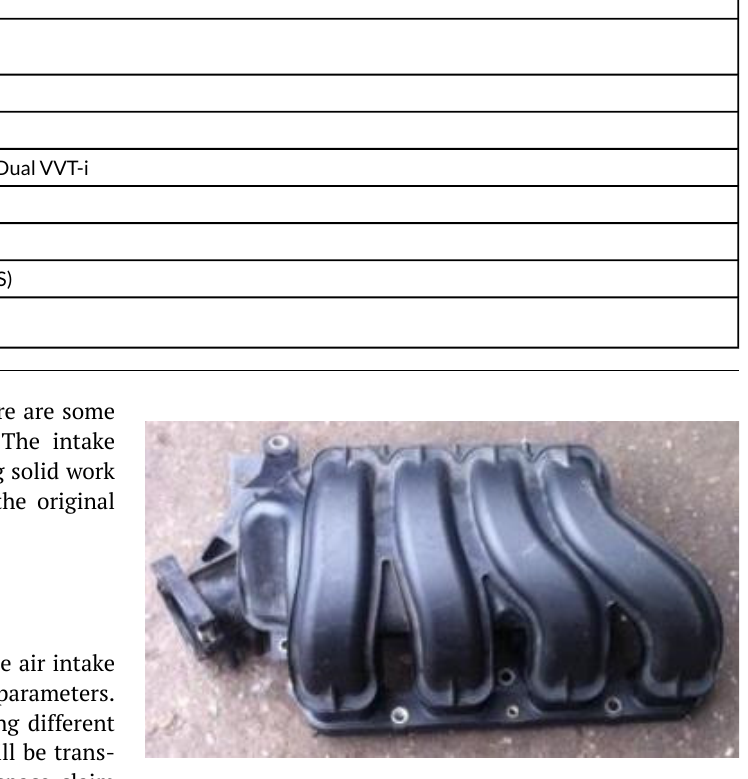
TABLE 1. ENGINE SPECIFICATIONS Engine (Type and Material)